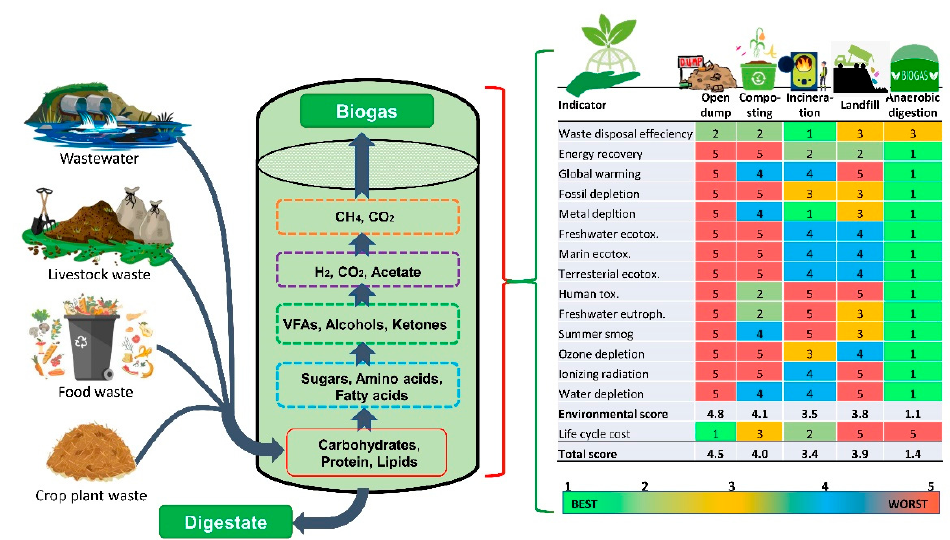
Figure 1. Comparing anaerobic digestion to other waste management routes using commonly used organic waste steams [28], copyright permission number 5345730119827.